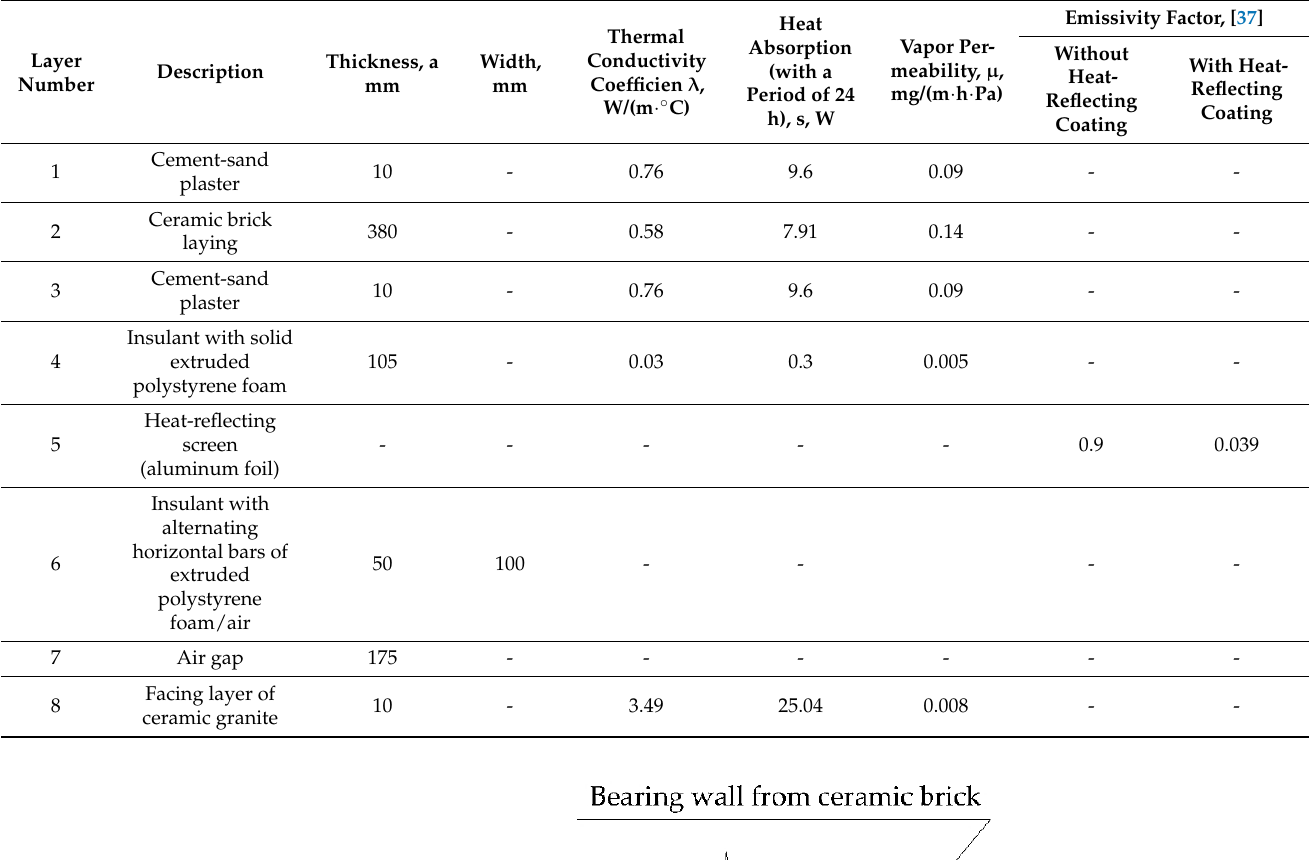
Table 3. Characteristics of the enclosing structure layers according to Figures 5 and 6 [36,37].